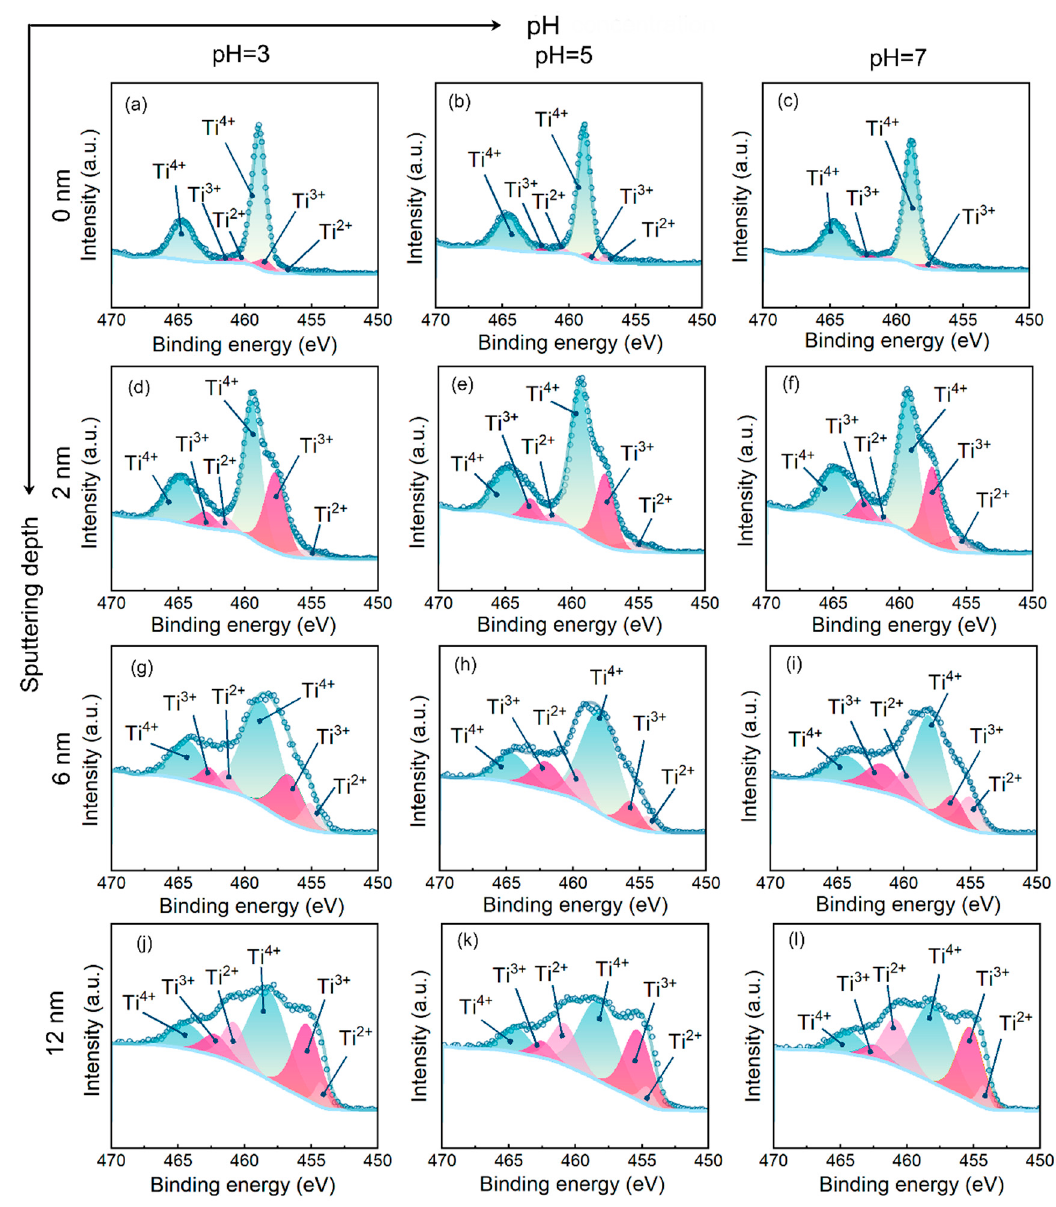
Figure 8. XPS spectrum of Ti 2p region for LPBFed Ti–6Al–4V after 1.0 V SCE PP tests in Hank’s solution, with pHs of 3, 5, and 7. Take figure ( a ) as the origin, the figures on the horizontal axis are the result of the solution pH value increases and the figures on the vertical axis is the result of increasing depth of sputtering.